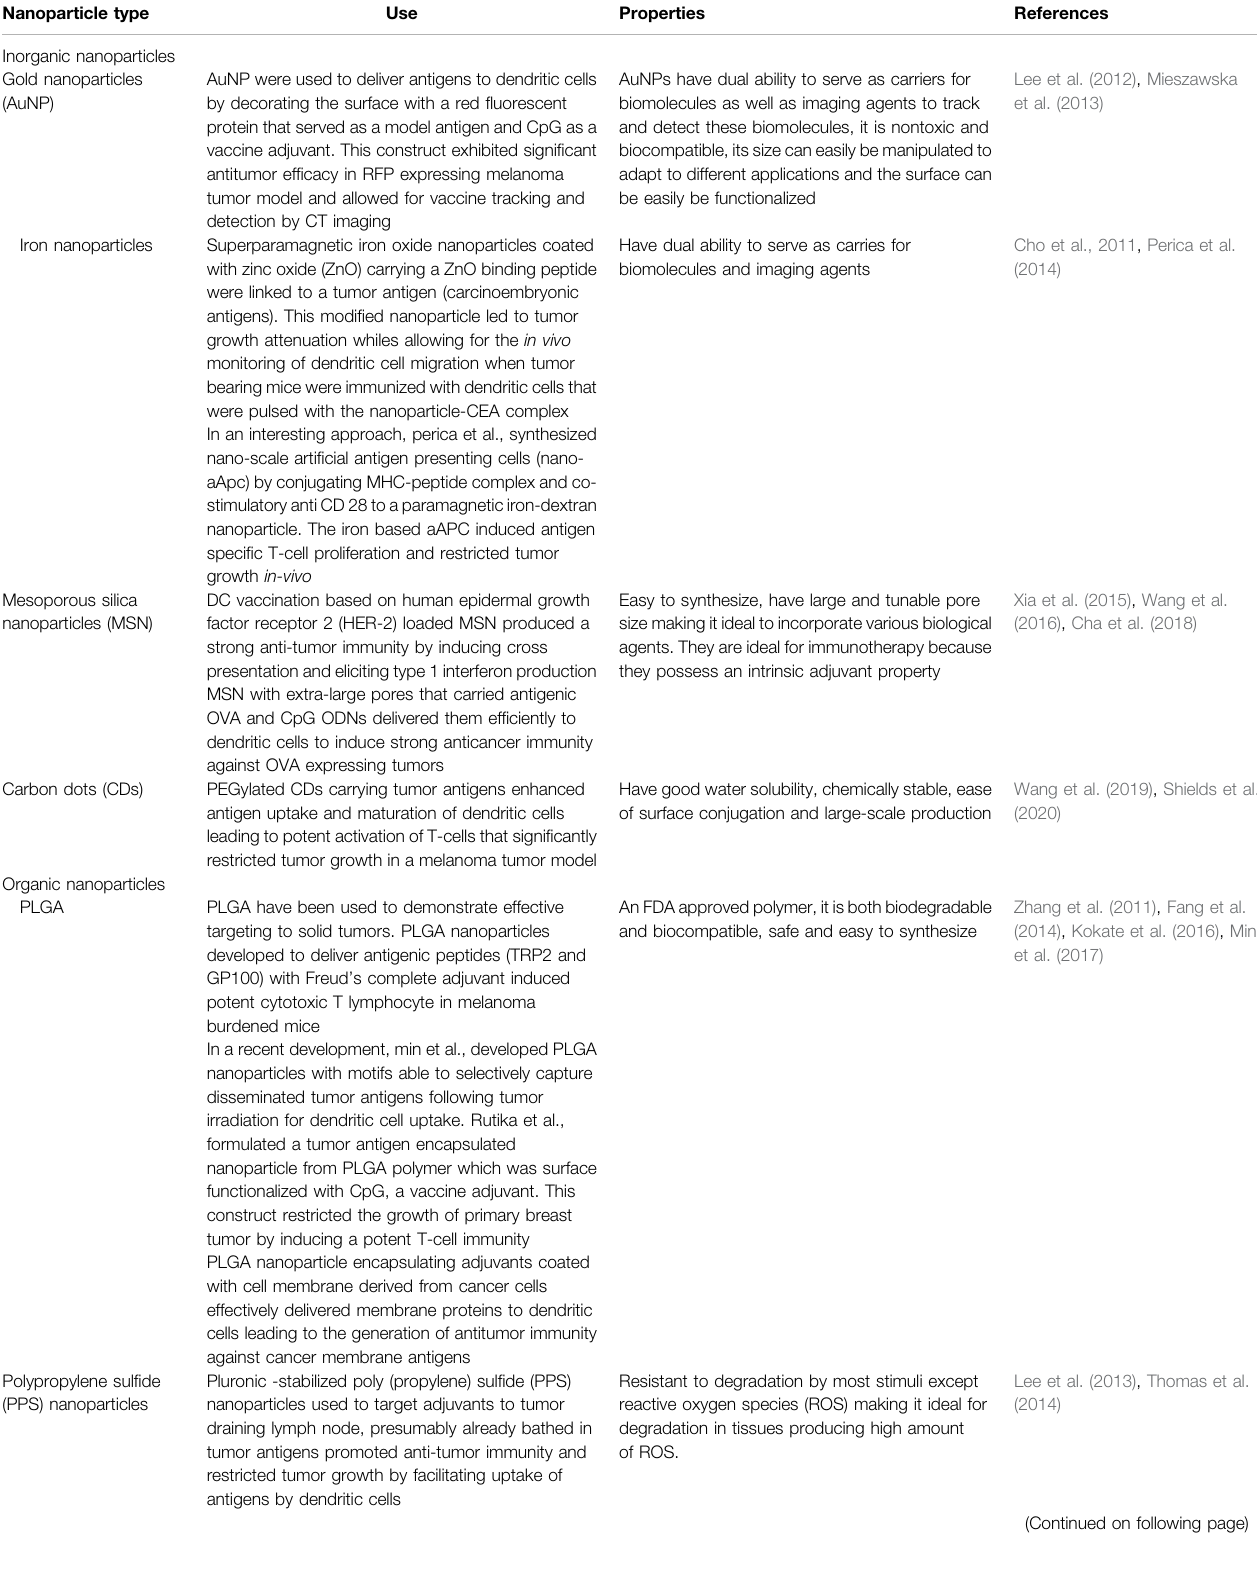
TABLE 3 | Nanoparticle platforms used in targeting tumor antigens to dendritic